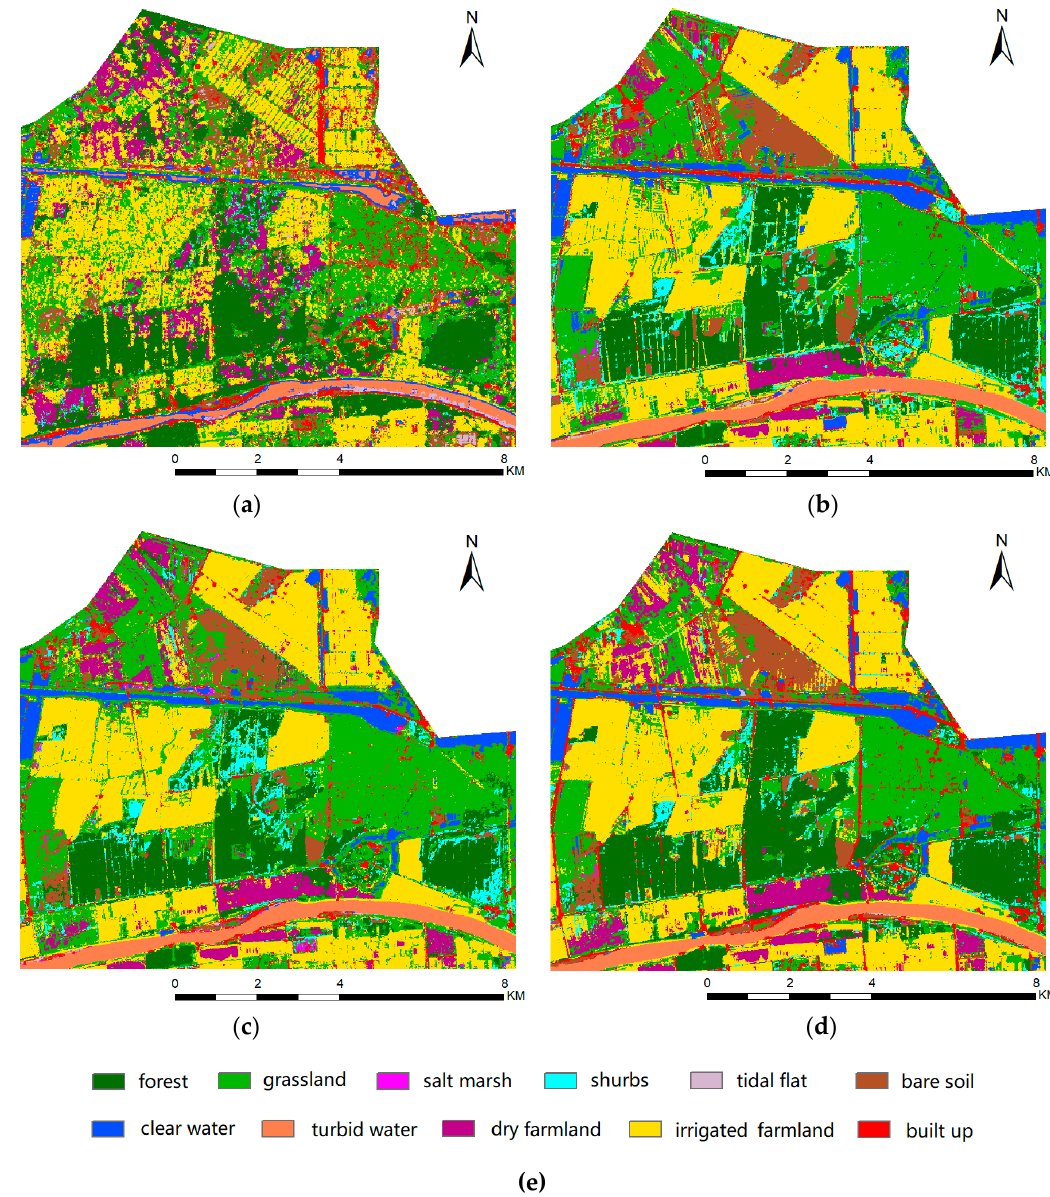
Figure 10. Details of the classification results for ( a ) radar-only, ( b ) optical-only, ( c ) feature-stacking, and ( d ) proposed MBCNN classification models; ( e ) legend.